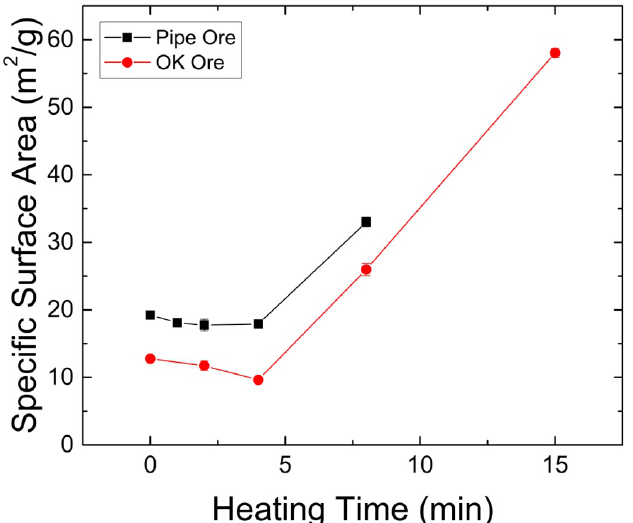
Figure 14. Specific surface area versus microwave heating time for Pipe and OK ores ground for 15 min [7].